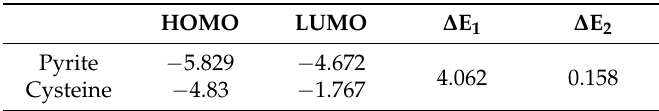
Table 2. Frontier orbital energies of pyrite (1 0 0) and cysteine.